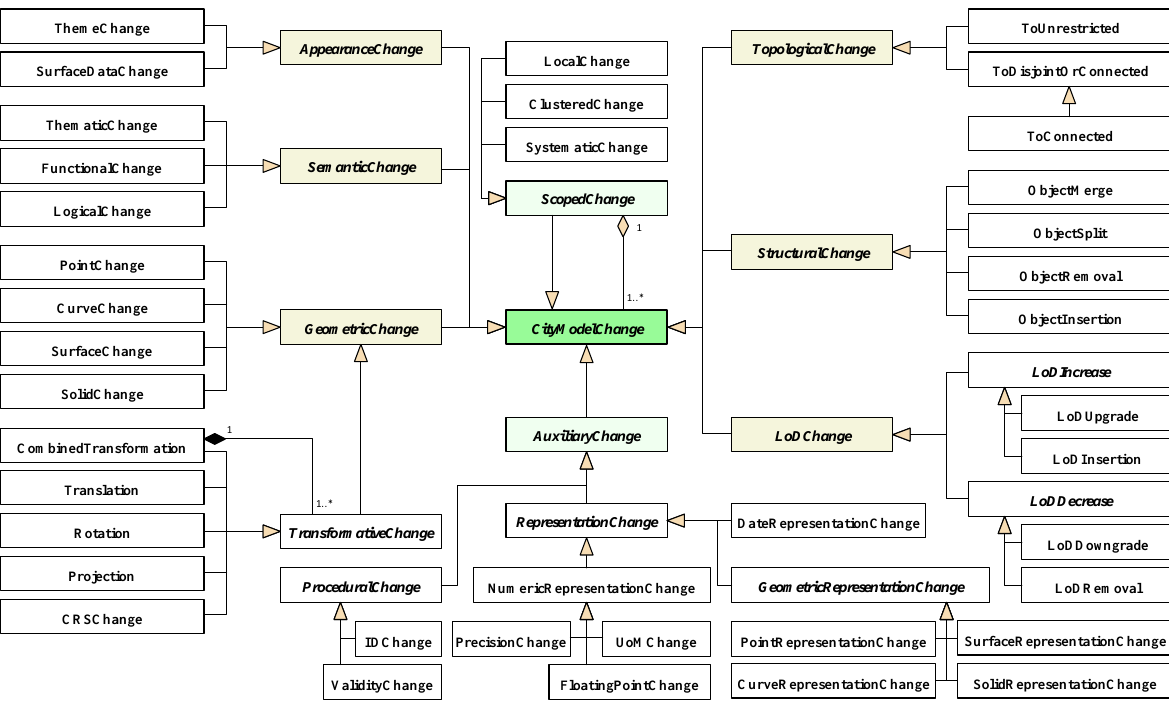
Figure 2. A UML class diagram of changes in semantic 3D city